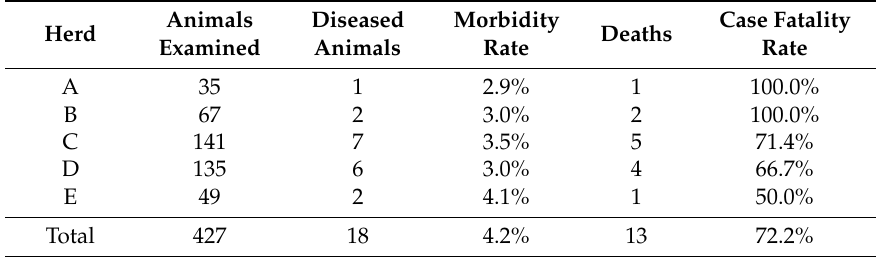
Table 3. Morbidity and case fatality rates by